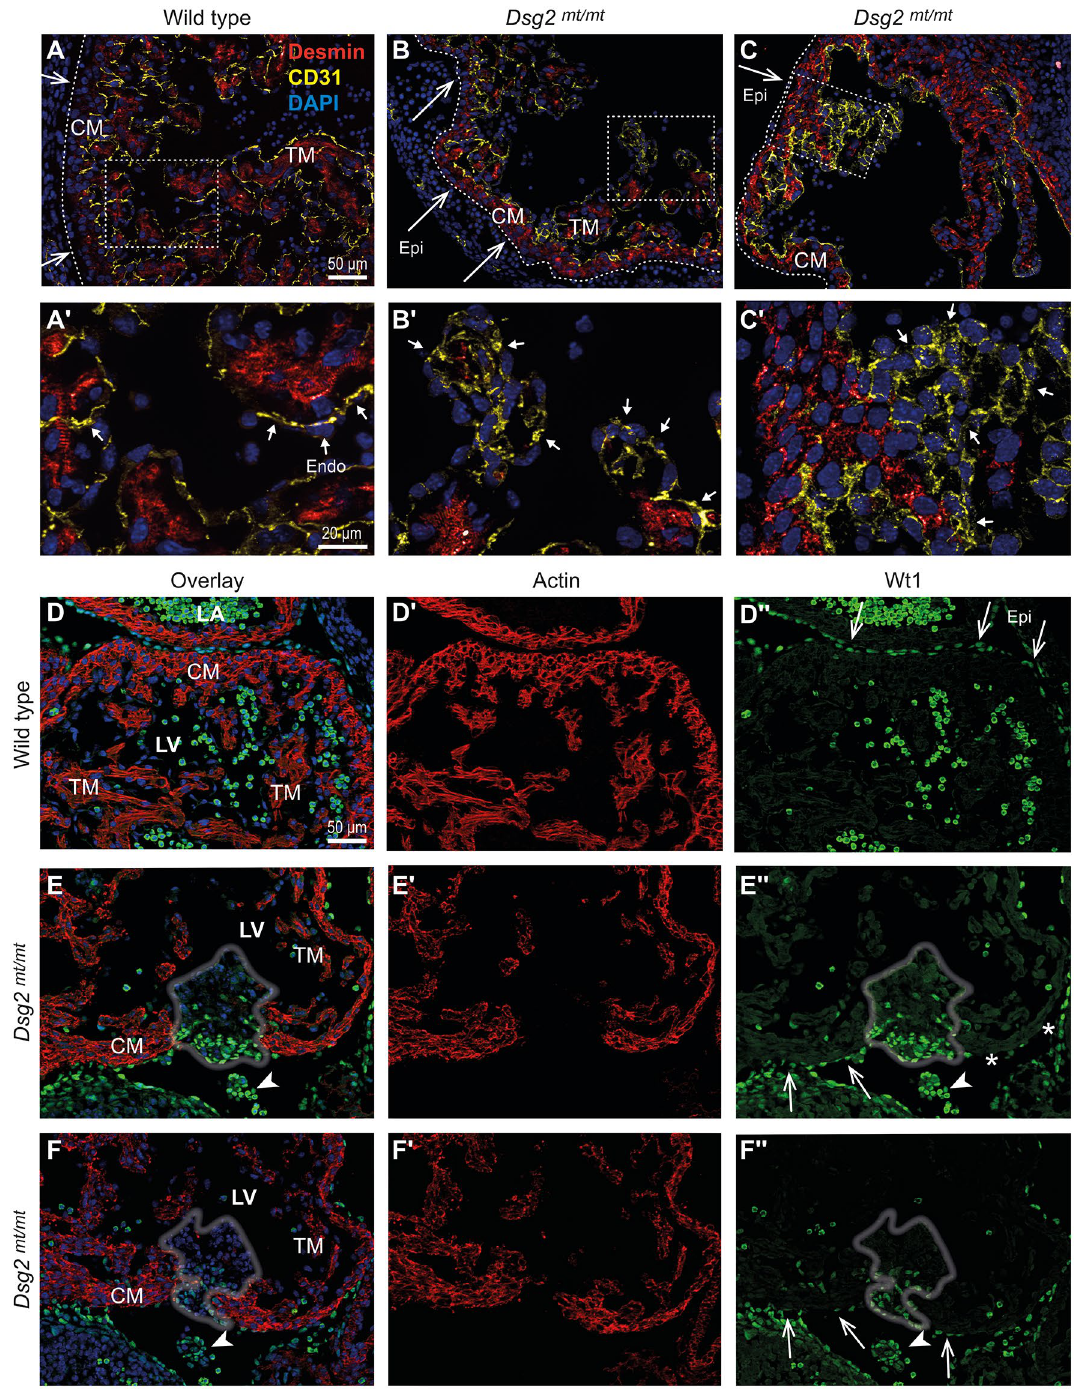
Figure 4. Endothelial CD31 + and epicardial Wt1 + cells expand in E11.5 Dsg2 mt/mt hearts. ( A – C ʹ ) The immunofluorescence micrographs detect desmin (red), CD31 (yellow) and nuclei (DAPI, blue) in wild-type and Dsg2 mt/mt hearts (high magnifications in A ʹ – C ʹ depict regions boxed in A – C ). Long arrows point to the epicardium (Epi; dashed lines), short arrows to the endocardium (Endo). In addition to CD31 + endothelial cells, CD31 + cell clusters are visible in the ventricle and atrium of Dsg2 mt/mt hearts in ( B ʹ ) and ( C ʹ ), respectively. Note the reduction of trabecular myocardium (TM) in ( B ) compared to ( A ). CM, compact myocardium. ( D – F ʺ ) Immunostaining of embryonic heart sections detects fetal cardiac actin (red), Wt1 (green) and nuclei (blue) in wild-type and Dsg2 mt/mt hearts. Note that the nucleated blood cells circulating in the heart chambers show strong green cytoplasmic autofluorescence, which differs from the nuclear Wt1 signal (long arrows in D ʺ ). The non-cardiomyocyte cell clusters are marked by gray contour lines in ( E , E ʺ , F , F ʺ ). An increased number of atypical Wt1 + cells are detected on the epicardial side of the cell clusters and a few scattered Wt1 + cells are also present inside the clusters. Note also, that the myocardium of Dsg2 mt/mt hearts shows regions without epicardial Wt1 + cells (asterisk in E ʺ ). Data are representative images of n = 5–6 hearts per group and analysis. Size bars, 50 µm in ( A ) (same magnification in B , C ); 20 µm in A ʹ (same magnification in B ʹ , C ʹ ); 50 µm in ( D ) (same magnification in D ʹ – F ʺ